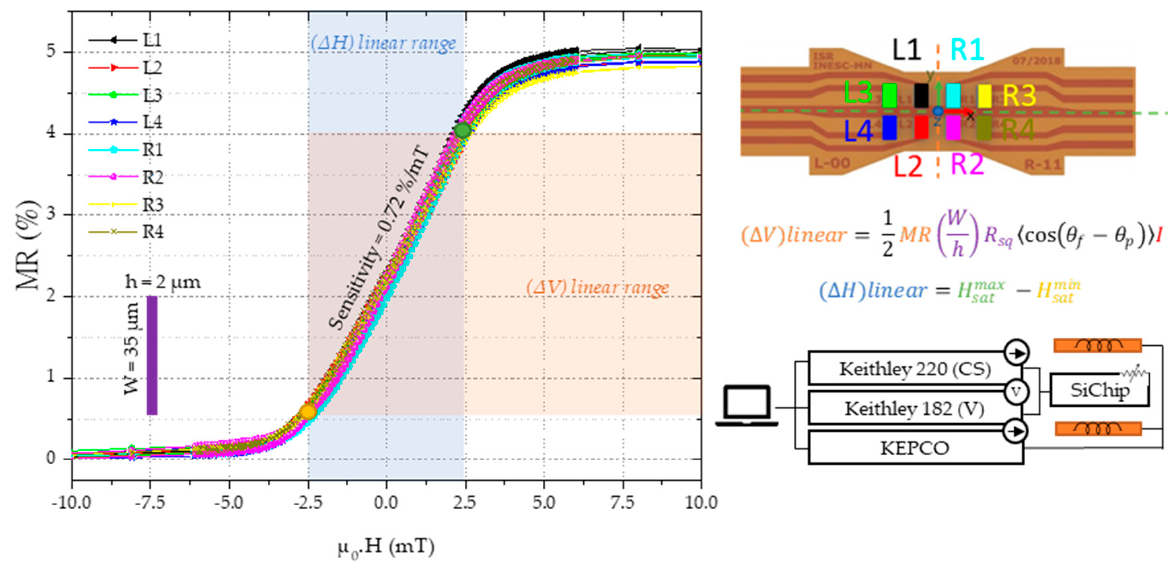
Figure 8. Transfer curve MR(H) curve of the used Si chips within a field range of ± 10 mT with a 1 mA current. The current to the sensor was supplied by a Keithley 220 programmable current source and the voltage was measured with a Keithley 182 sensitive digital voltmeter, while the current provided to the Helmholtz coils responsible for controlling the applied field ( µ 0 .H) is a KEPCO bipolar operational power supply.